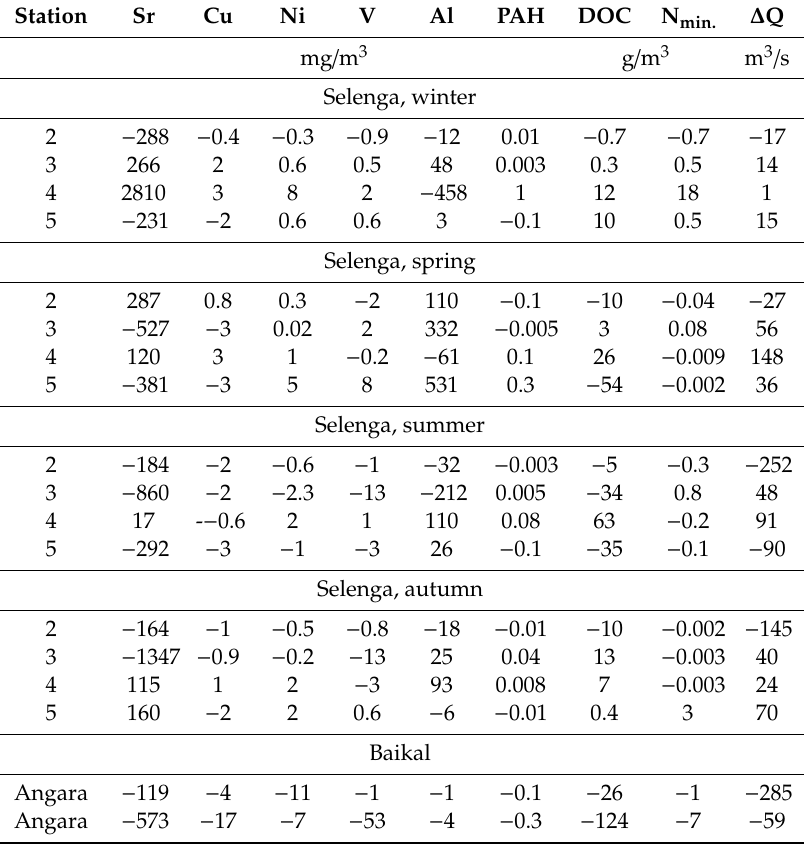
Table 7. Values of contaminant removal capacity of the Selenga River and Lake Baikal, and ∆ Q values used for calculations.